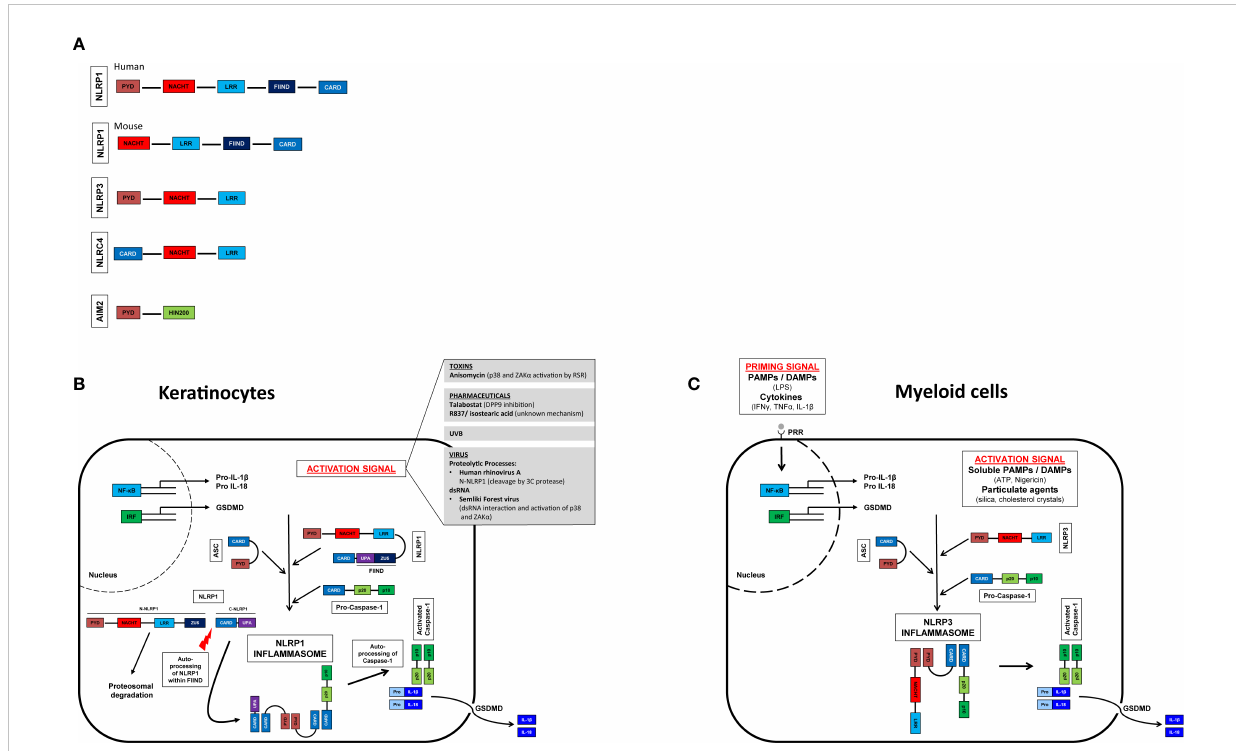
FIGURE 1 In fl ammasome activation in myeloid cells and keratinocytes and their domain structure. Domain structure of human and murine NLRP1 (nucleotide- binding domain and leucine-rich repeat [NLR], pyrin domain [PYD] containing protein 1), NLRP3 (NLR family PYD domain containing protein 3), NLRC4 (NLR family caspase CARD [Caspase recruitment domain] domain containing protein 4), AIM2 (Absent in melanoma 2). GSDMD, gasdermin D (A) . Activation signals lead to oligomerization of the sensor (NLRP1/NLRP3) with ASC and caspase 1. Self-activation of caspase 1 and subsequent activation of pro-IL-1 b and pro-IL-18. Pore formation in the cell membrane allows secretion of mature IL-1 b and IL-18. Myeloid cells (C) , unlike keratinocytes (B) , do not constitutively express pro-IL-1 b and pro-IL-18 and therefore require a priming step (41,